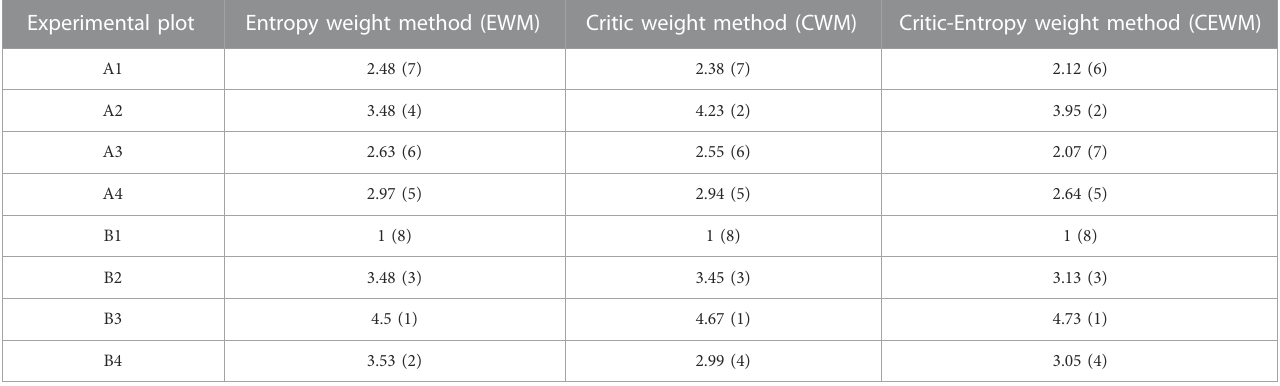
TABLE 4 Comprehensive evaluation and